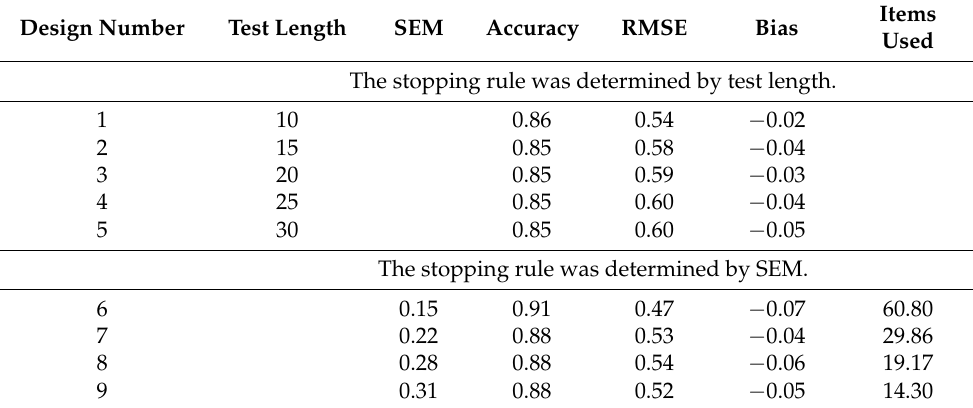
Table 5. Accuracy and efficiency of CAT for the equivalence